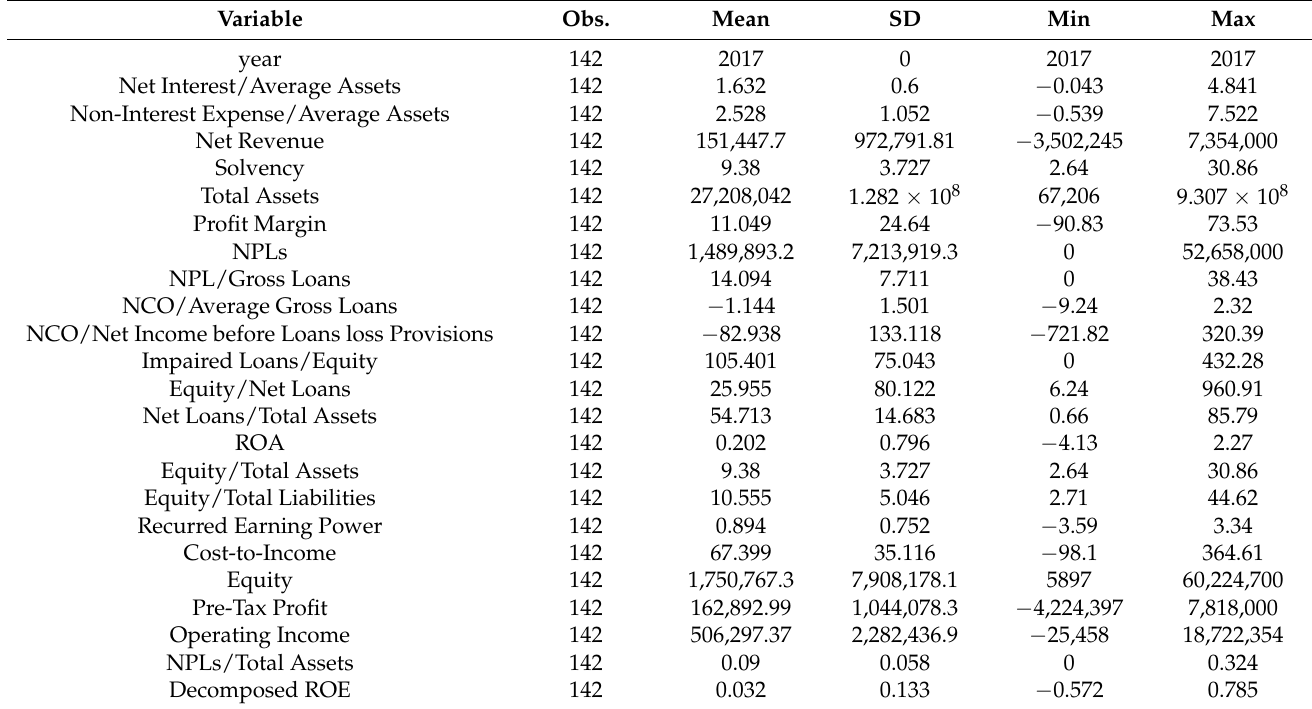
Table A7. Descriptive statistics for the 142 Italian banks for the year 2017. Variable